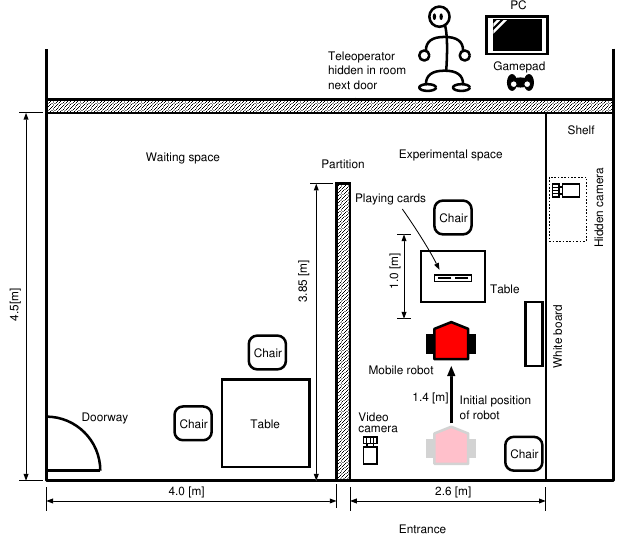
Teleoperator hidden in room next door